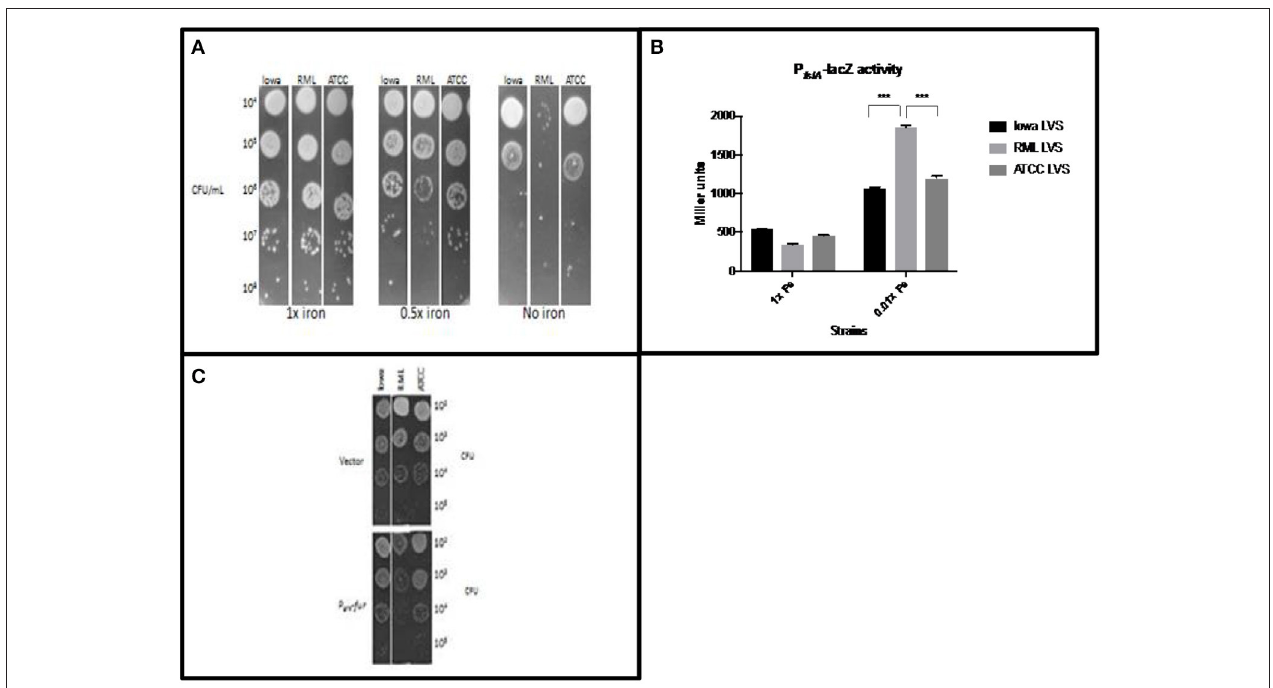
FIGURE 1 | RML LVS has relatively less intracellular iron than other LVS biovars. (A) Bacteria were grown overnight in standard MMH broth, serially diluted in sterile PBS and plated for enumeration on MMH agar with 0.025%, 0.0125%, or no added Fe 3 + PP i . Data from a representative experiment is shown. (B) Miller assay for each LVS carrying a plasmid with the Fur regulated P fslA -lacZ reporter. Bacteria were grown overnight in Chamberlain’s defined medium with 35 µ M (high iron) or 350nM (low iron) FeSO 4 . Two-way ANOVA with Sidak’s multiple comparisons was used to test for significance. Shown is a representative Miller assay from replicate experiments. (C) Strains overexpressing fur were grown in MMH broth overnight, serially diluted into sterile PBS and plated on standard MMH agar. Shown are representative data from two similarly designed